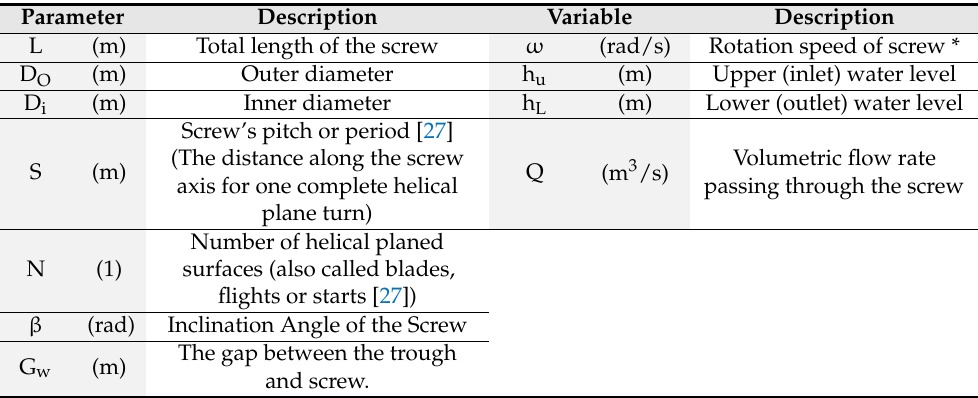
Table 1. Required parameters to define Archimedes screws’ geometry and operating variables.